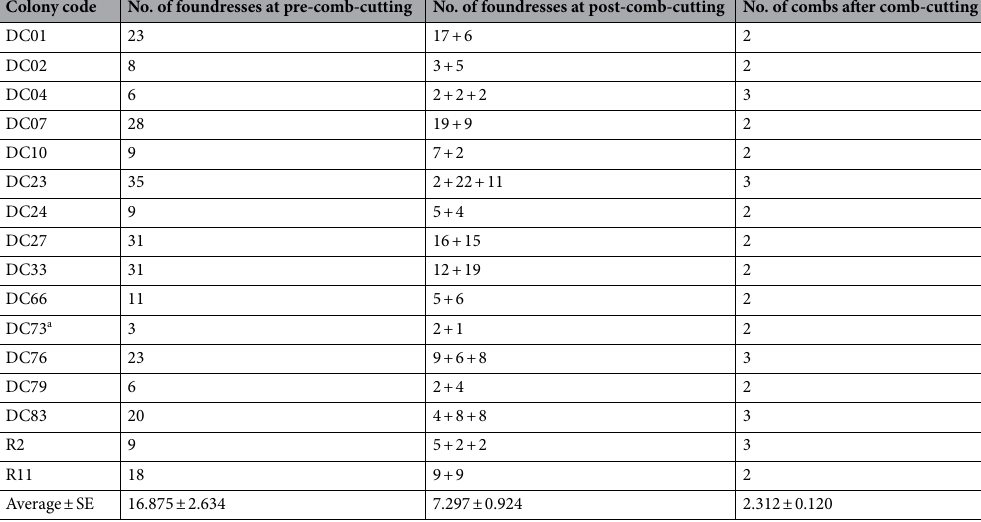
Table 1. The number of foundresses at pre-comb-cutting and those at post-comb-cutting for 16 original colonies of Roplalidia plebeiana . Each colony consisting of a single old comb was divided into two or three new combs. a This colony was excluded from the relatedness calculation for within combs and between combs because only one foundress was observed in a new comb in post-comb-cutting.